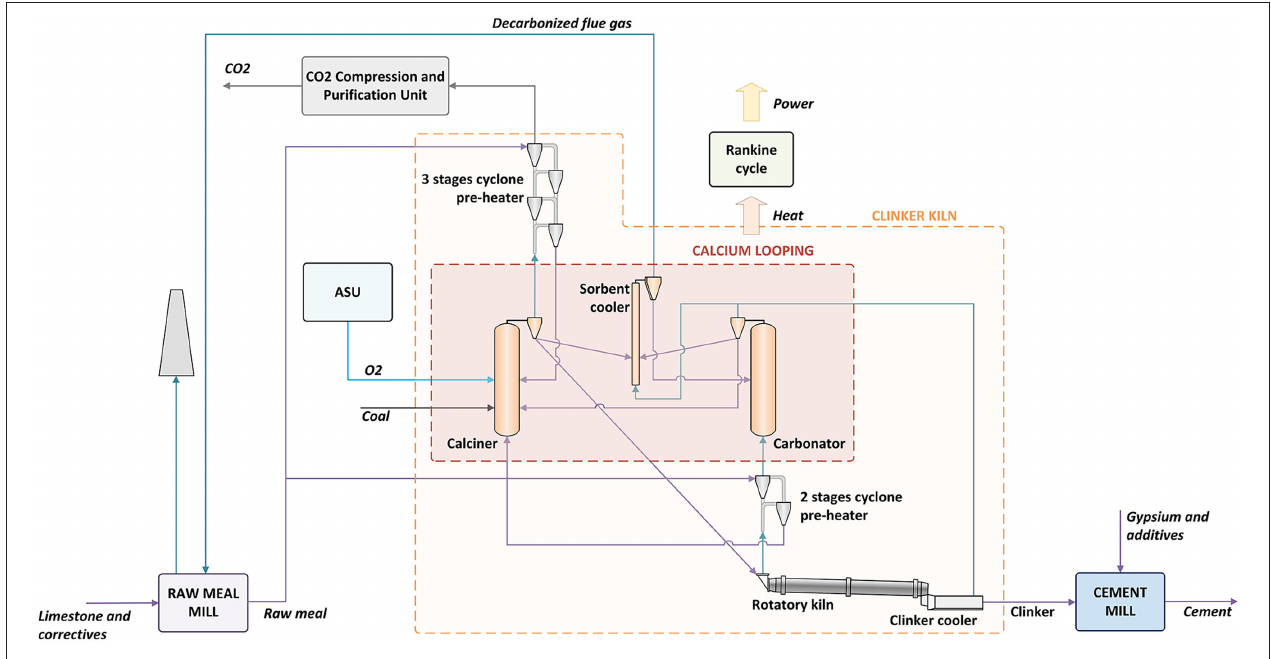
FIGURE 4 | Calcium looping integrated